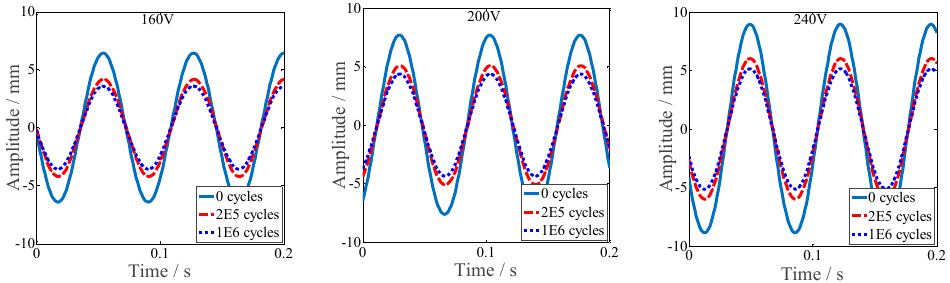
Figure 6. Tip displacement time history of the beam specimen actuated by MFC under cyclic load (stress amplitude 24 MPa).